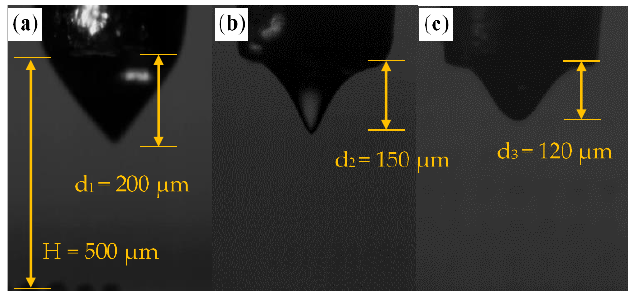
Figure 3. Different sizes of Taylor cones from different materials recorded by a high-speed camera: ( a ) microcrystalline wax (MC-Wax); ( b ) polycaprolactone (PCL); ( c ) polymathic methacrylate (PMMA).